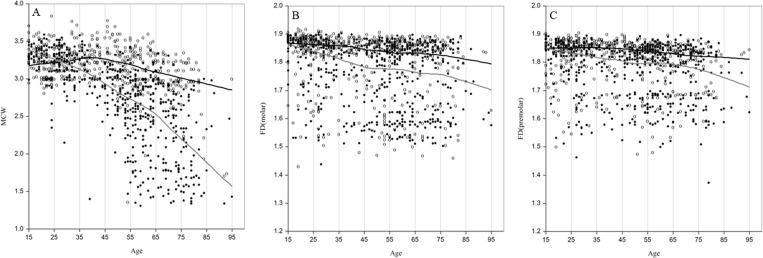
Age and gender specific changes in cortical and trabecular variables of the mandible in men and women.(A) Mandibular cortical width (MCW). (B) Fractal dimension (FD) of trabecular bone at molar region. (C) Fractal dimension of trabecular bone at premolar region. Curve fitting was done with a Loess smoother function. Individual values and smoother lines are given for men using open circles and solid lines (black) and for women using closed circles and solid lines (grey).